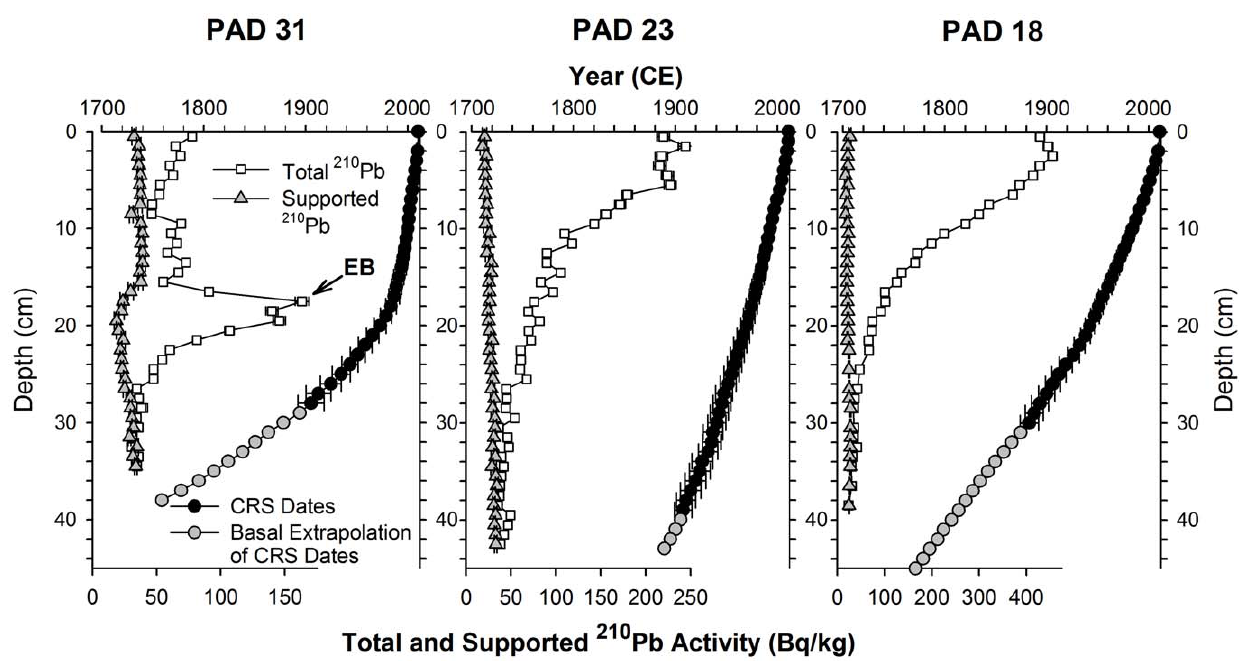
Figure 2. Sediment core dating. 210 Pb activity (supported and total (=supported + unsupported)) and depth-age profiles for sediment cores taken from the three study lakes (PAD 31, PAD 23, PAD18) in the Peace-Athabasca Delta, northern Alberta (error bars= 6 2 SD). The irregular 210 Pb activity profile for PAD 31 is a result of an increase in sedimentation rate associated with increased flooding following the Embarras Breakthrough in 1982 [27].